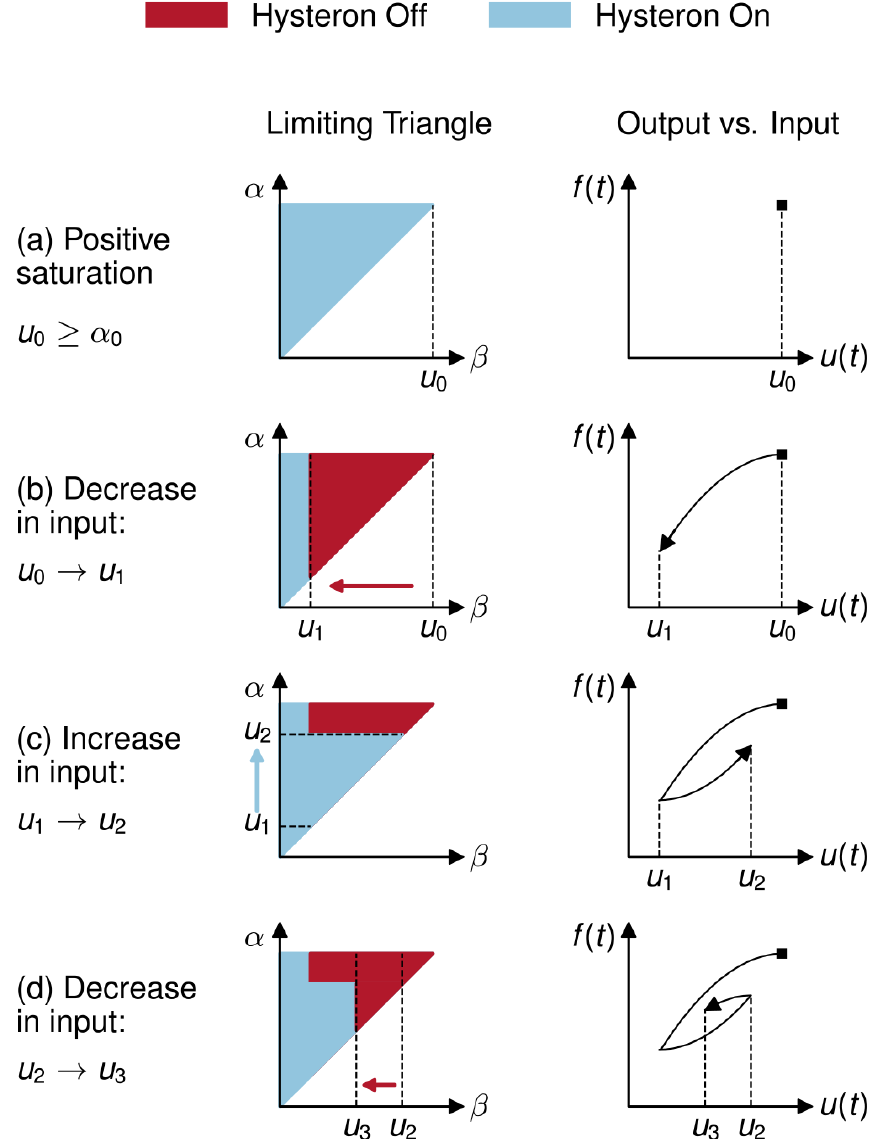
Figure 2. The Preisach model can be geometrically interpreted over the α ≥ β half-plane, such that output, f , is the fraction of the limiting triangle in which hysterons are on. Changes to input, u , result in swipes on the limiting triangle (left-hand column). When u decreases, hysterons are turned off by swiping left. When u increases, hysterons are turned on by swiping up. Output corresponds to the fraction of the hysterons that are on (right-hand